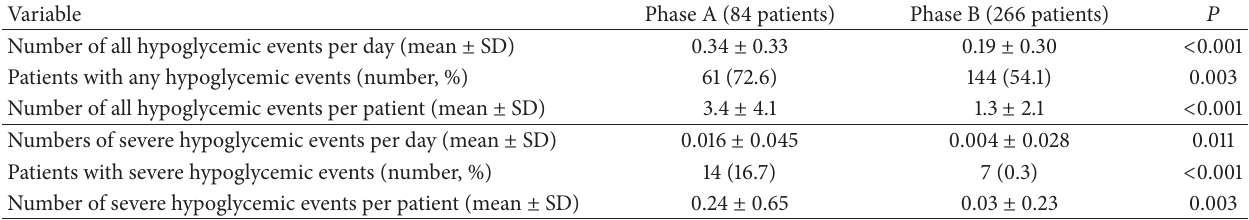
Table 2: All hypoglycemic (blood glucose < 70mg/dL) and severe episodes (blood glucose < 40 mg/dL) during phase A and phase B. Variable